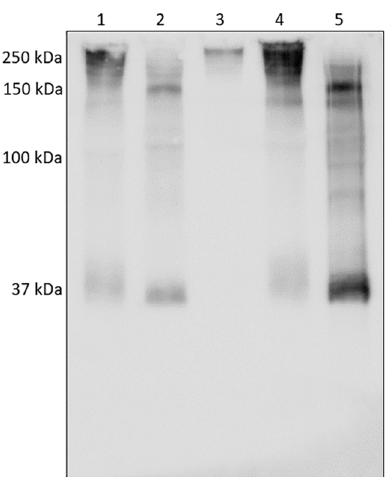
Figure 2. Western blotting with anti ‐ HNE antibody. Five different COVID ‐ 19 samples show the presence of proteins in the range between 130 and 280 kDa which complexed with HNE.